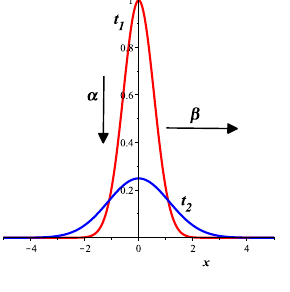
Figure 1. A self-similar solution of Equation (2.1) for t 1 < t 2 . The presented curves are Gaussians for regular heat conduction.